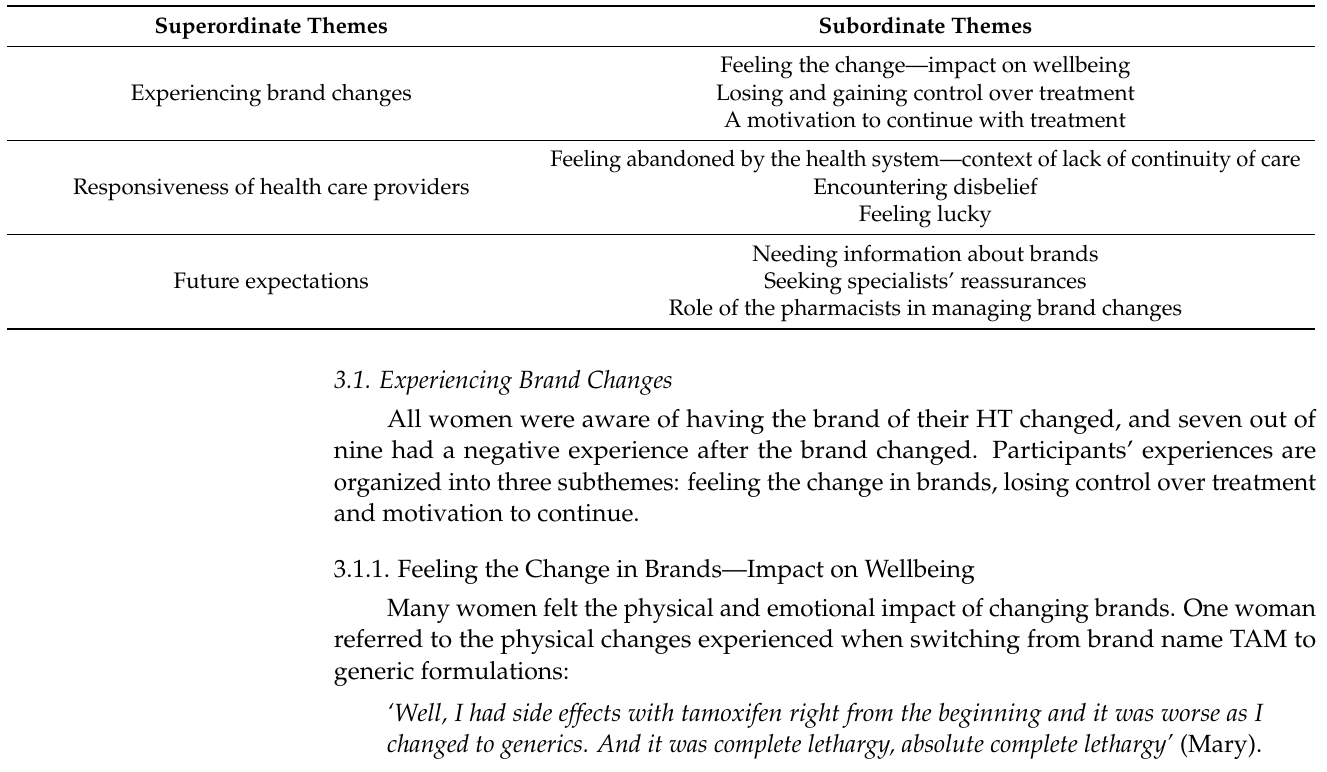
Table 2. Superordinate and subordinate